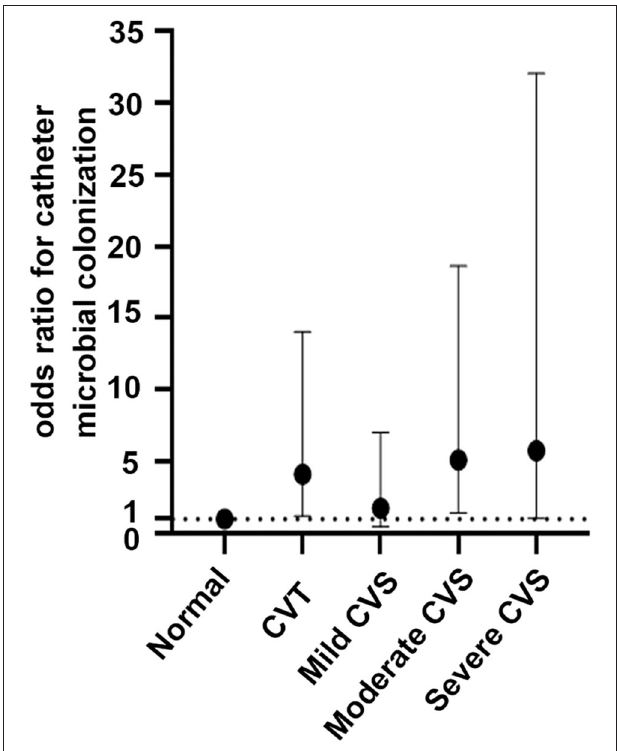
FIGURE 2 | Odds ratios for catheter microbial colonization across the central venous diseases. A dashed reference line for normal is drawn at OR, 1. Mild CVS: OR, 1.76; 95% CI, 0.44–7.02; P = 0.425; moderate CVS: OR, 5.13; 95% CI, 1.41–18.63; P = 0.013; severe CVS: OR, 5.77; 95% CI,